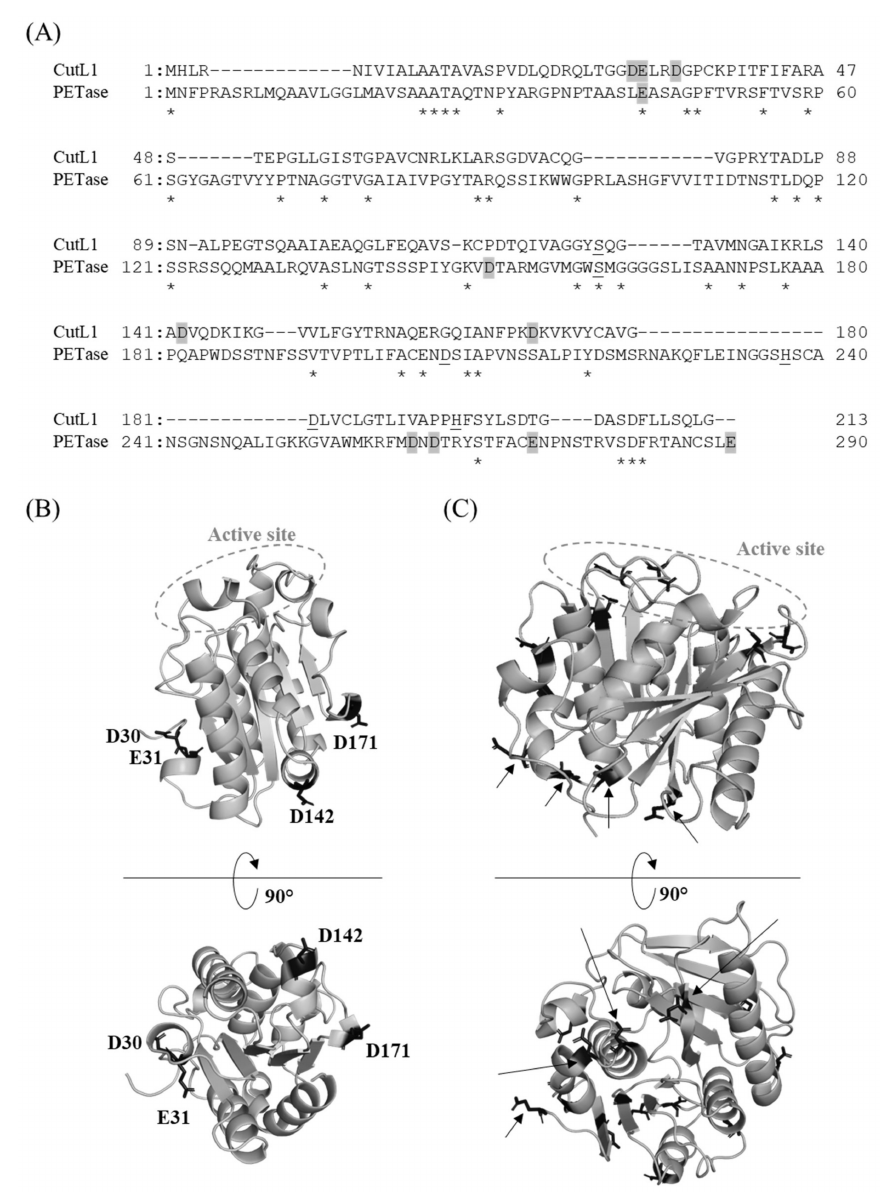
Figure 4. Amino acid sequences and three-dimensional structures of CutL1 and PETase. ( A ) Align- ment of the amino acid sequences. Identical residues are indicated by asterisks. Negatively